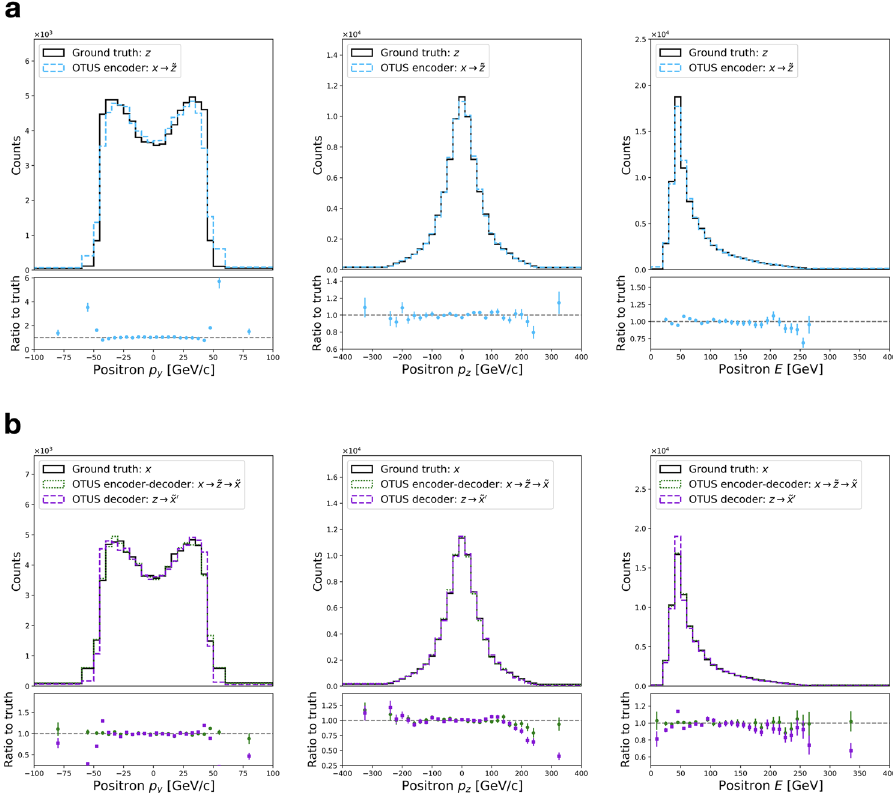
Figure 3. Performance of OTUS for Z → e + e − decays. ( a ) Matching of the positron’s p x , p y , and E distributions in Z . It shows distributions of samples from the theoretical prior, { z ∼ p ( z ) } (solid black), as well as the output of the encoder, {˜ z } ; the encoder transforms samples of testing data in experimental space, X , to the latent space, Z , and is shown as x → ˜ z (dashed cyan). ( b ) Matching of the positron’s p x , p y , and E distributions in X . It shows the testing sample { x ∼ p ( x ) } (solid black) in the experimental space, X , as well as output from the decoder applied to samples drawn from p ( z ), labeled as z → ˜ x ′ (dashed purple). Also shown are samples passed through both the decoder and encoder chain, x → ˜ z → ˜ x (dotted green). Dotted green and solid black distributions are matched explicitly during training. Enhanced differences between dashed purple and solid black indicate the encoder’s output needs improvement, as p E ( z ) does not fully match p ( z ). If performance were ideal, the distributions in every plot would match up to statistical fluctuations. Residual plots show bin-by-bin ratios with statistical uncertainties propagated accordingly (see